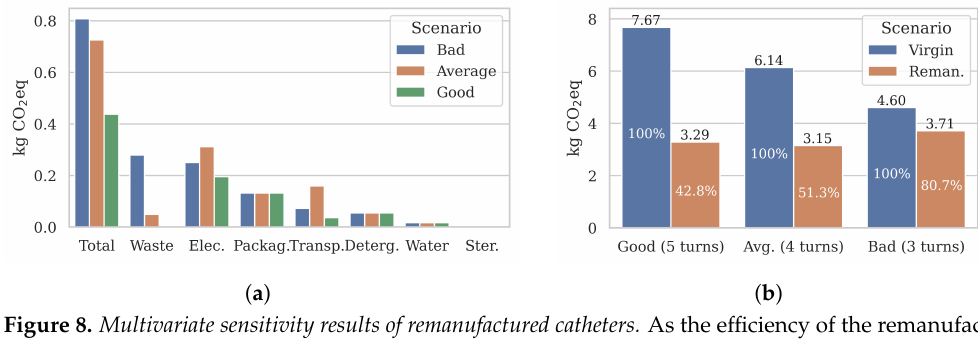
Figure 8. Multivariate sensitivity results of remanufactured catheters. As the efficiency of the remanufac- turing process improves (see Table 7), the emission savings of remanufactured catheters improves compared to an equivalent number of virgin catheters ( E f v · N ). Remanufacturing reduces emissions